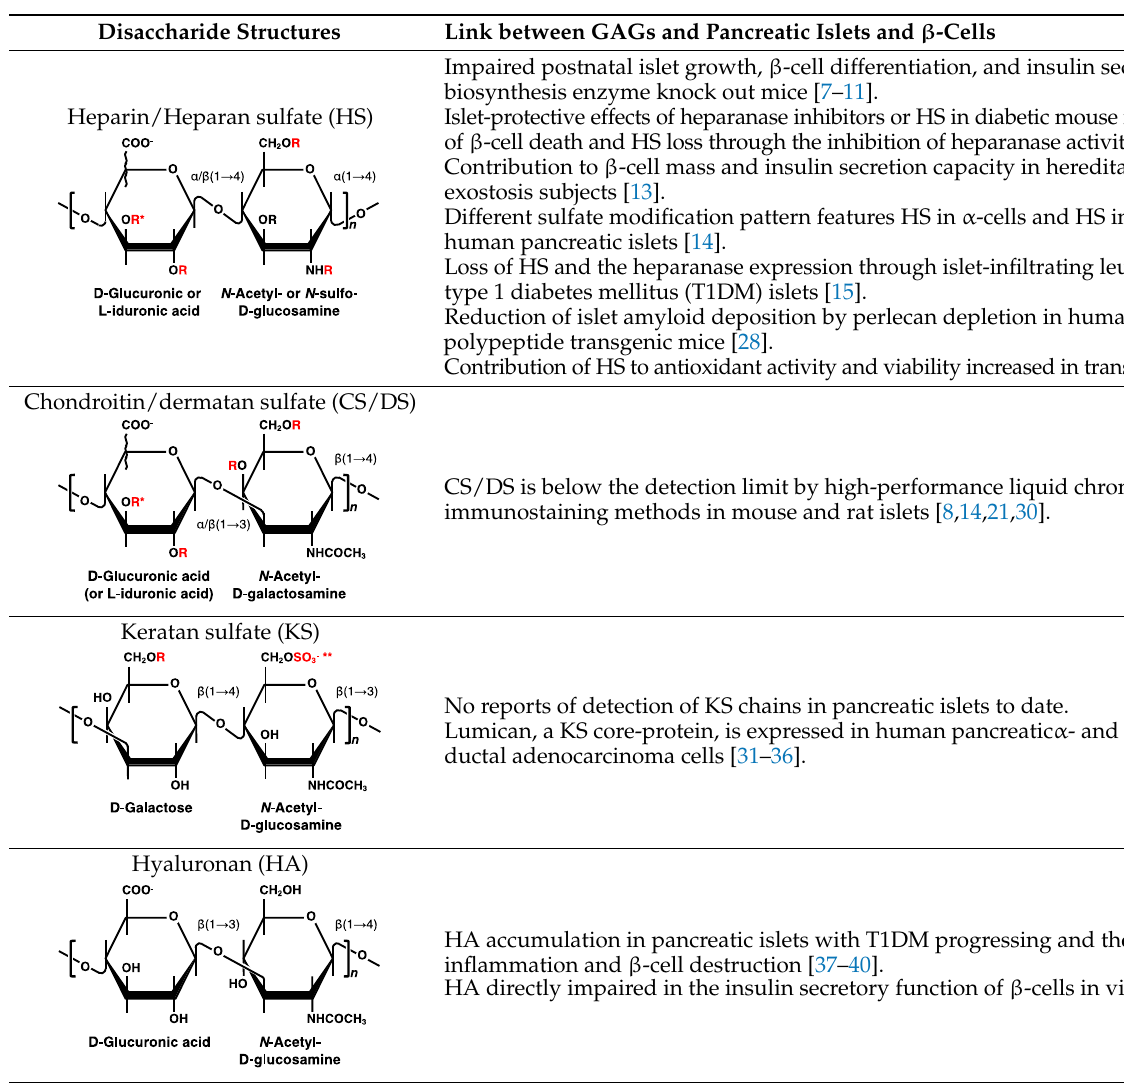
Table 1. Features affected by GAGs in pancreatic islets and β -cells.